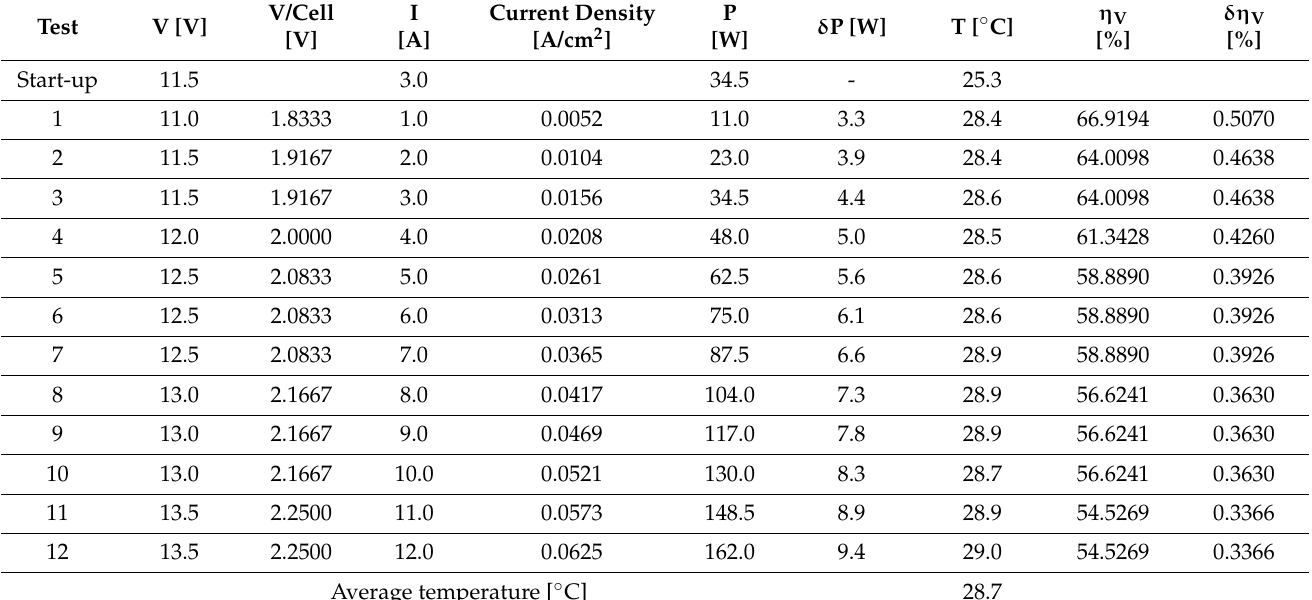
Table 8. Results obtained for the calculation of the theoretical efficiency ( η U ) of the dry cell for 3% ( w/w ) of KOH. The letter “ δ ” means the experimental error of a given variable.